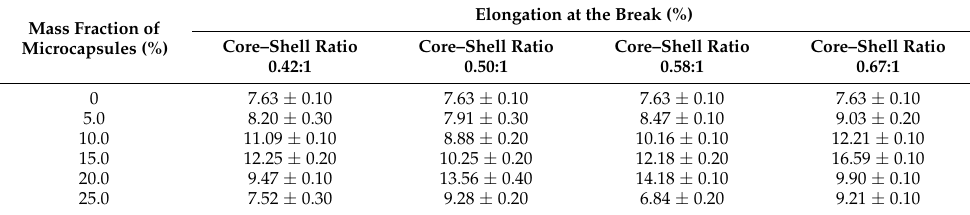
Table 6. The elongation at the break of the